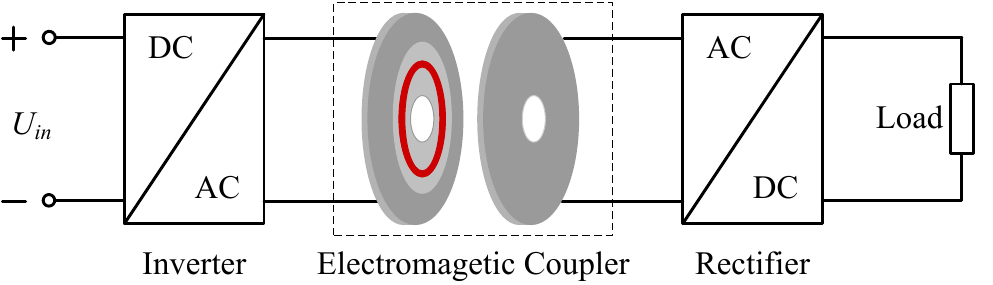
Figure 1. Configuration diagram of a wireless power transfer (WPT)